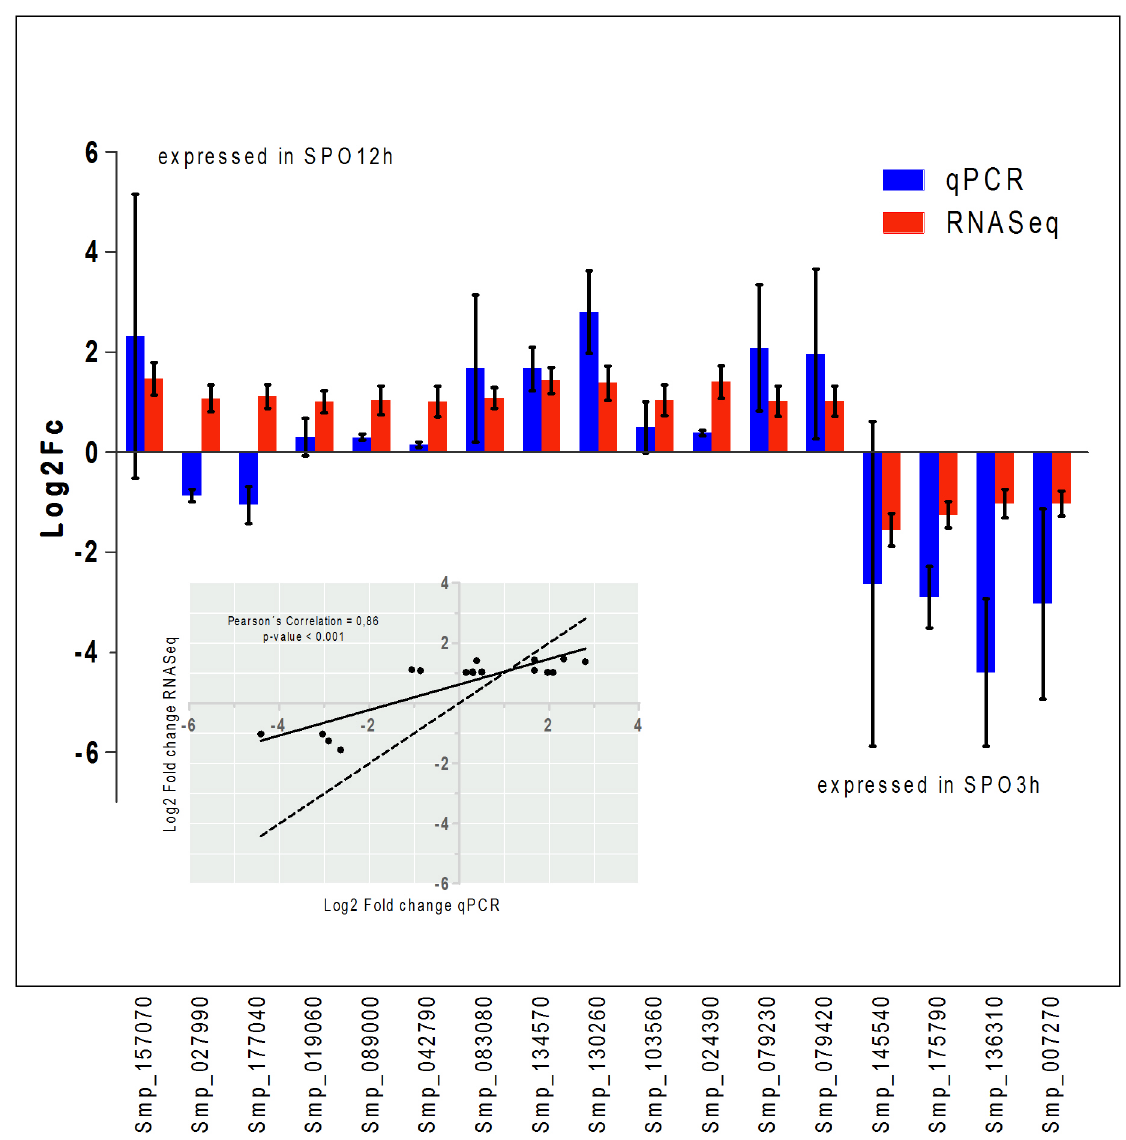
Fig 3. Relative expression of a subset of genes as determined by RNASeq and qPCR assays. Bar plots of Log2ChangeFold of the subset of geneschosen to validate the RNASeq (red) pattern of expressionby using qPCR (blue). The Pearson’s coefficient, at a 95% confidencelevel is shown on the graph and illustrates the gene expressionassessedby both methods. The scatter plot shows the strong correlationof gene expressioncalculatedby the two methods (Pearson’s correlation= 0.86, p- value < 0.001). The solid line is the linear regressionadjustedto the points of correlation;the dashedline represents a correlation where x = y.